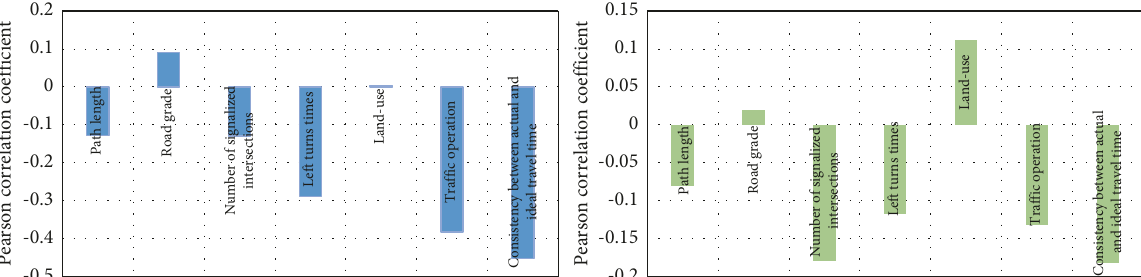
Figure 2: Correlation analysis of private car and taxi.